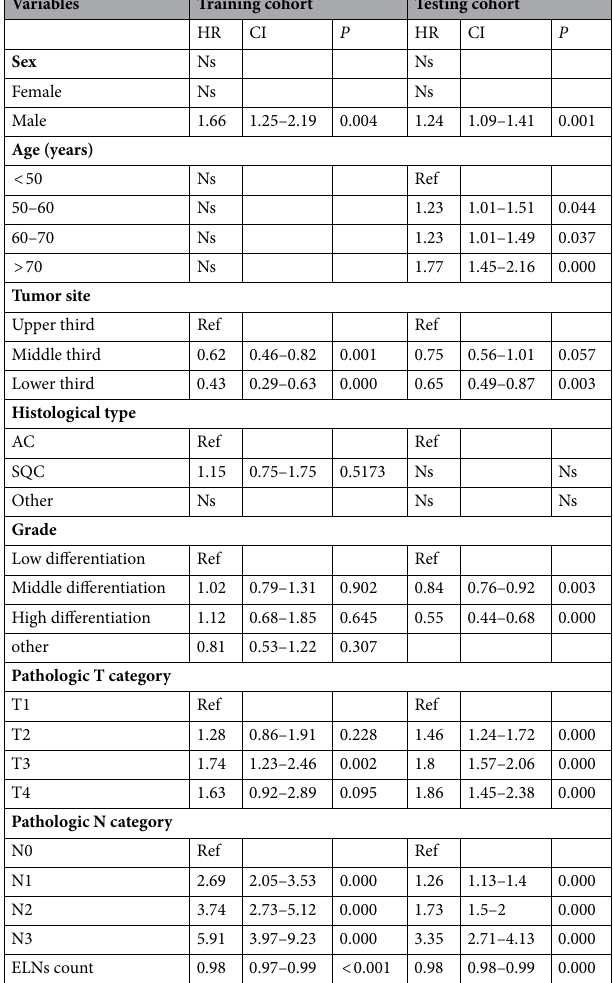
Table 2. Multivariate Cox regression analysis of lymphadenectomy number on OS in the two cohorts. SQC Squamous-cell carcinoma, AC Adenocarcinoma, AJCC American Joint Committee on Cancer, ELNs count Examined lymph nodes